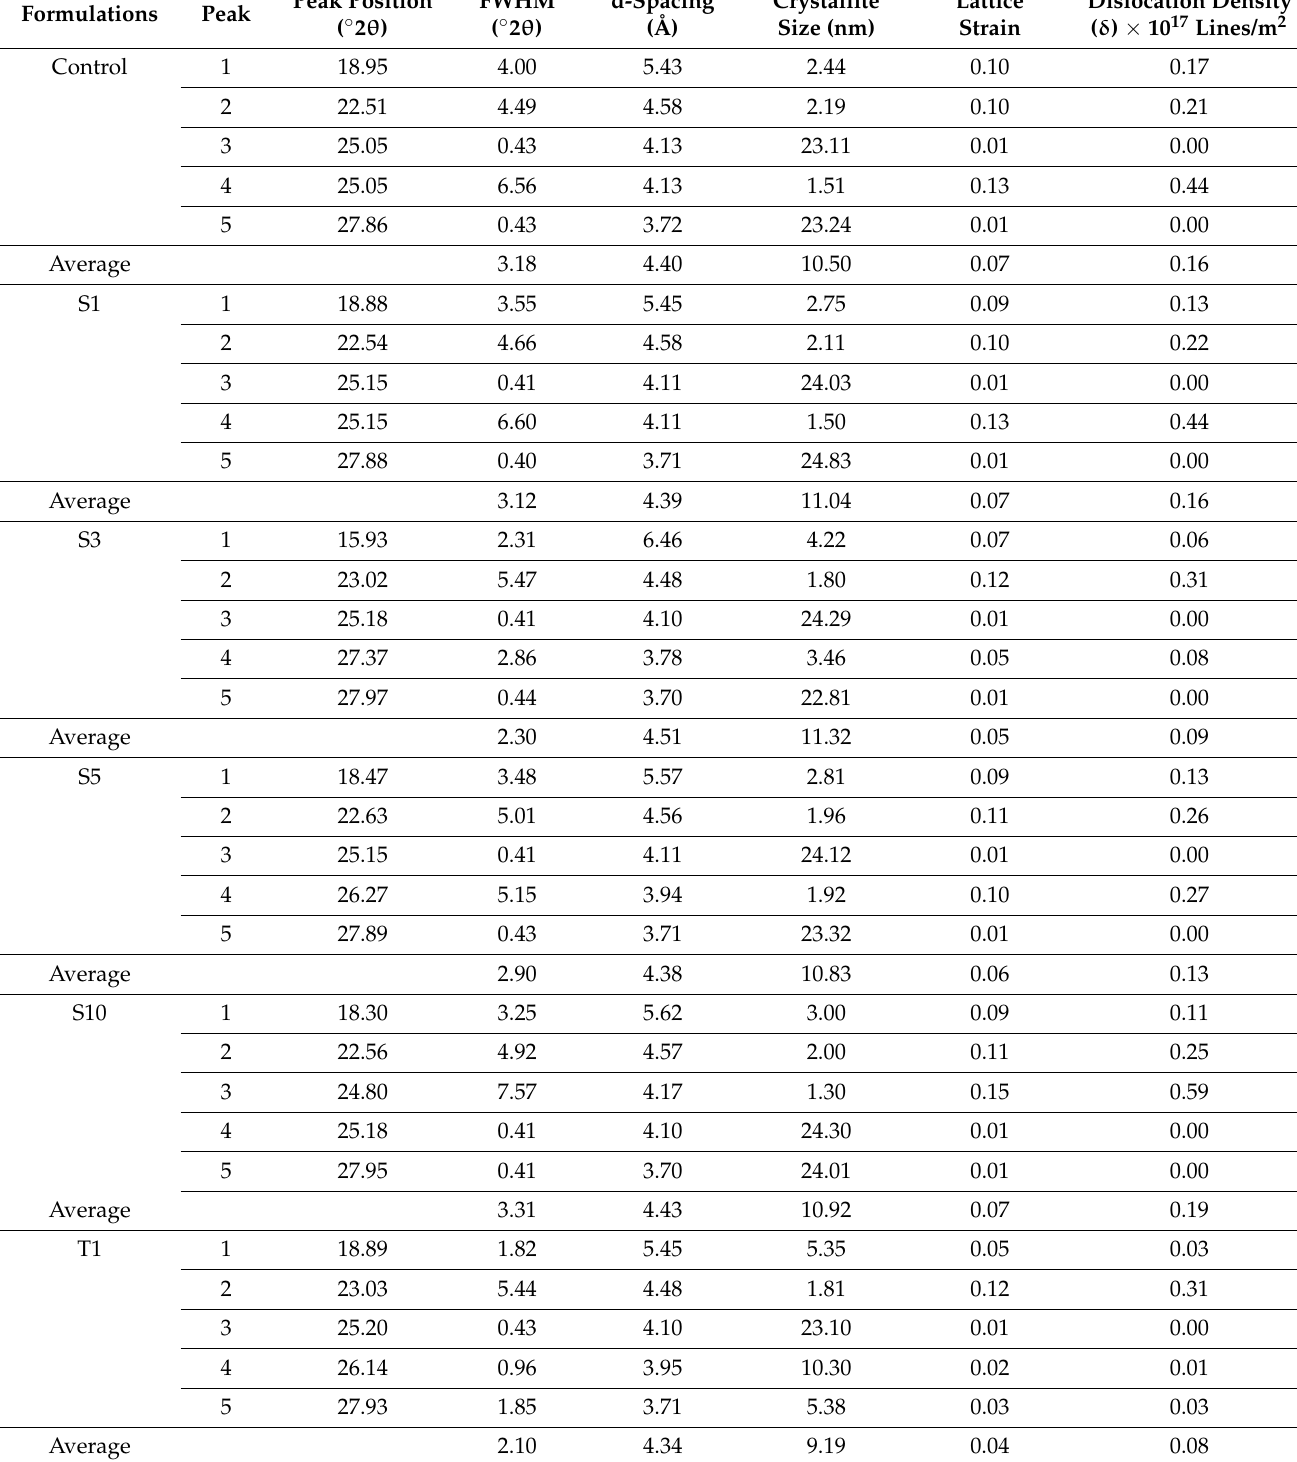
Table 2. XRD parameters obtained from deconvoluted